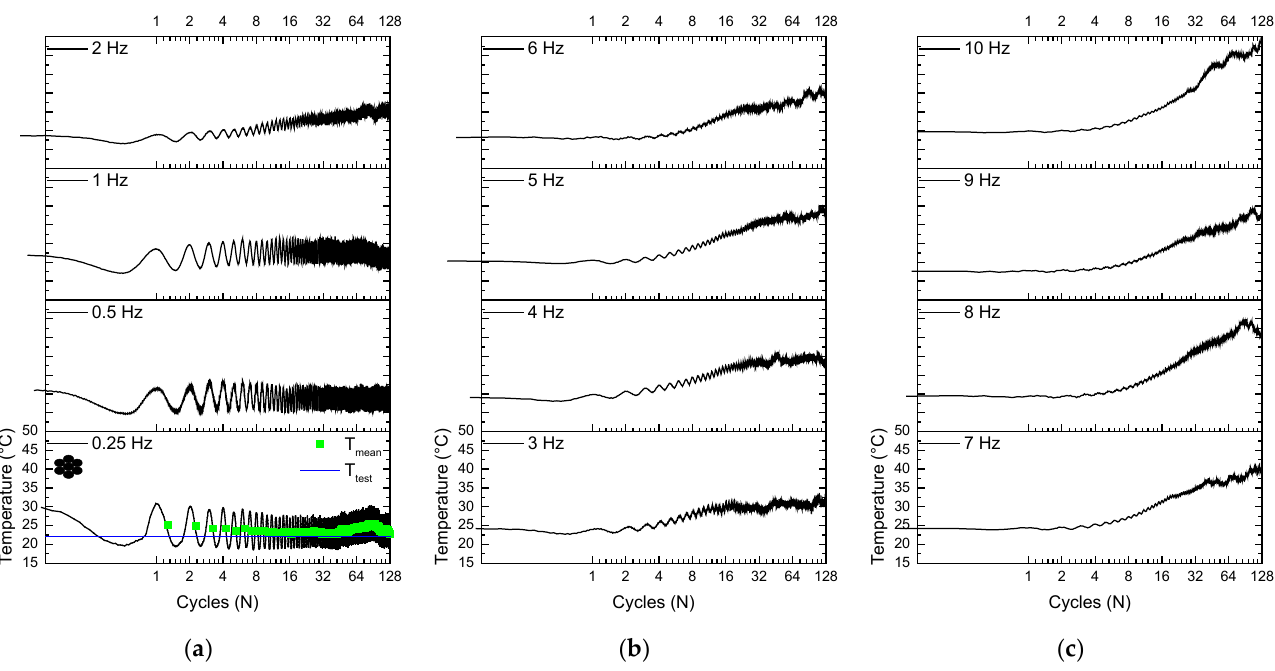
Figure 9. Temperature response during cycling of the NiTi SMA micro cable. ( a ) From 0.25 Hz to 2 Hz. ( b ) From 3 Hz to 6 Hz. ( c ) From 7 Hz to 10 Hz. Note that the mean temperature increases with the evolution of the cycles, and the temperature variation amplitude reduces with the increase of the loading frequency. The temperature signal starts above the room temperature of 22 ± 2 °C and then decreases. This is due to the 5% pre-strain applied at a low strain rate (equal for all tests), which increases the starting temperature, and soon after the unloading to 2.5% and then load to 7.5%, closing the first cycle.